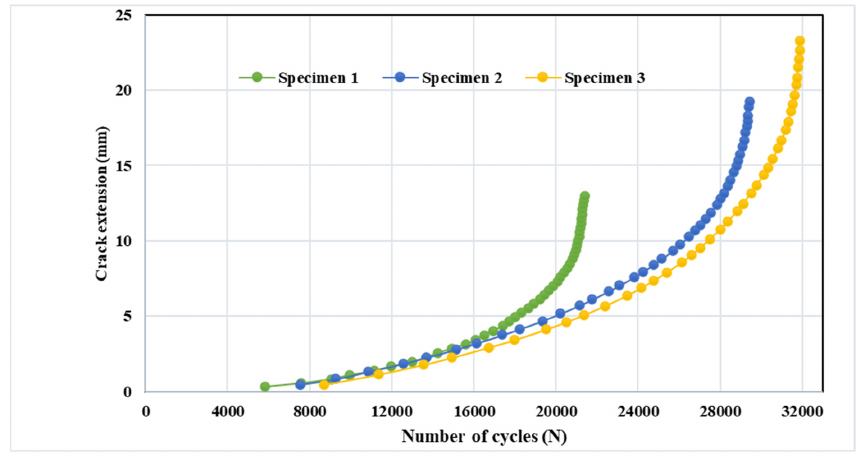
Figure 11. Predicted fatigue life cycles for the three specimens under stress ratio R = 0.